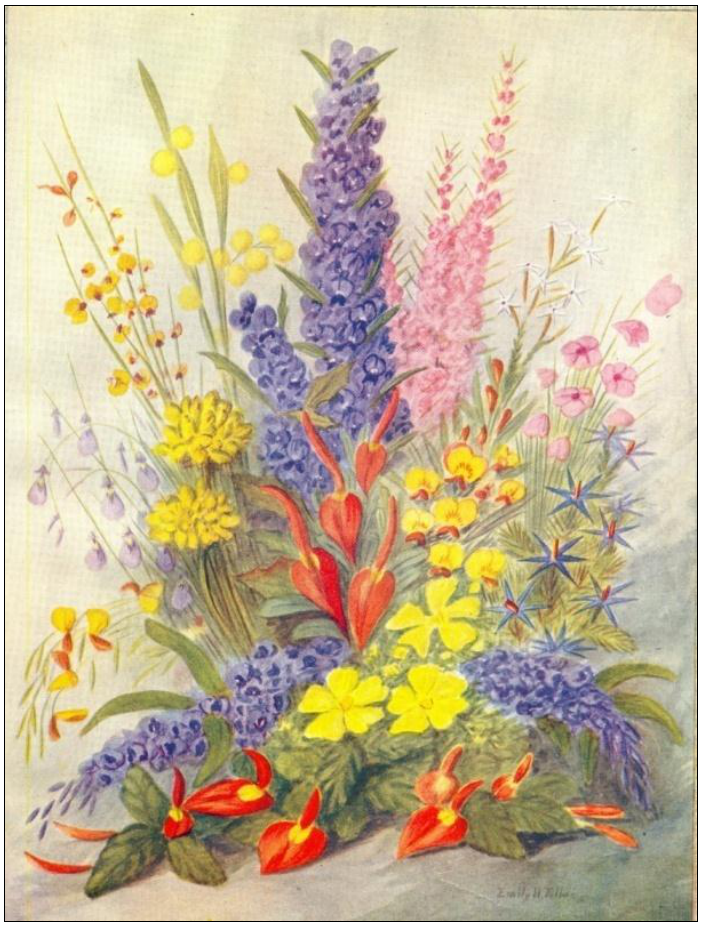
Figure 6 . Plate from Emily Pelloe’s Wildflowers of Western Australia with sixteen species